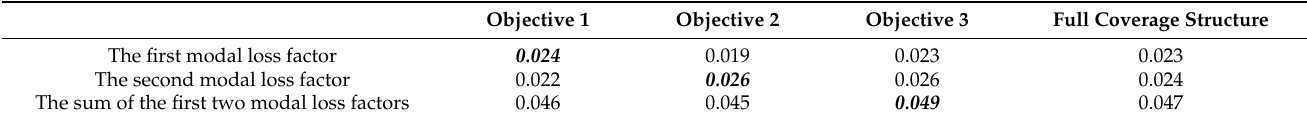
Table 3. Comparison of the modal loss factors between optimized structure and full coverage structure (bold italics denote the modal loss factor of objective mode).